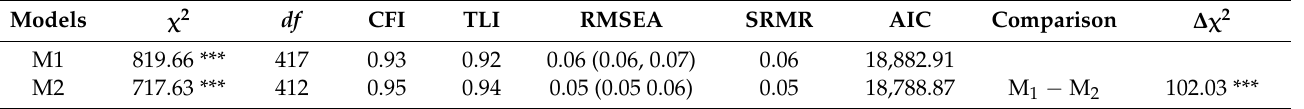
Figure 2. Structural equation model direct effects. Note. * p < 0.05; ** p < 0.01; *** p < 0.001. Straight arrows indicate significant direct effects; dotted arrows indicate non-significant direct effects; curved arrows indicate error correlations. Ovals indicate latent variables; squares indicate observed variables. Table 2. Model